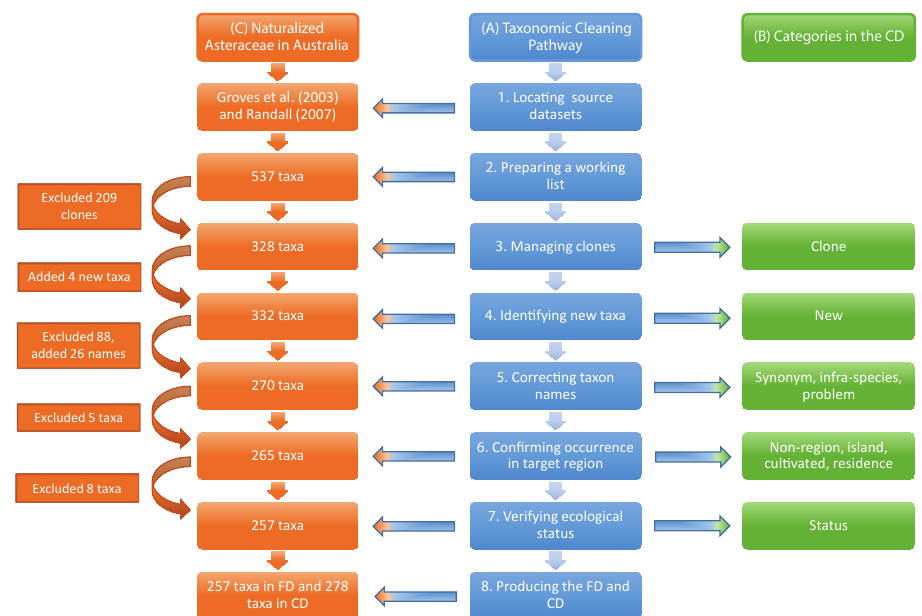
Figure 1. A Flowchart of the eight steps in the taxonomic cleaning protocol B Ten categories in the companion dataset that are populated with taxon names during the cleaning process, located adjacent to relevant steps in the protocol C A walkthrough of the case study of naturalized Asteraceae in Australia, with a numerical breakdown of the taxa in the working list at each step to the production of the final and companion